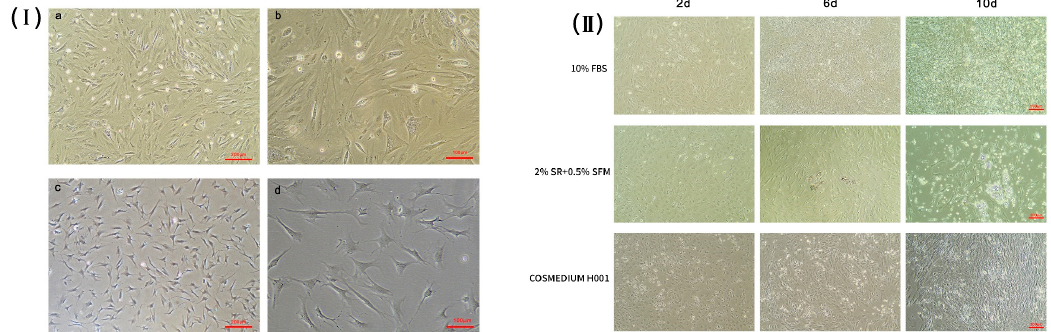
Table 2. miRNA-specific reverse transcription